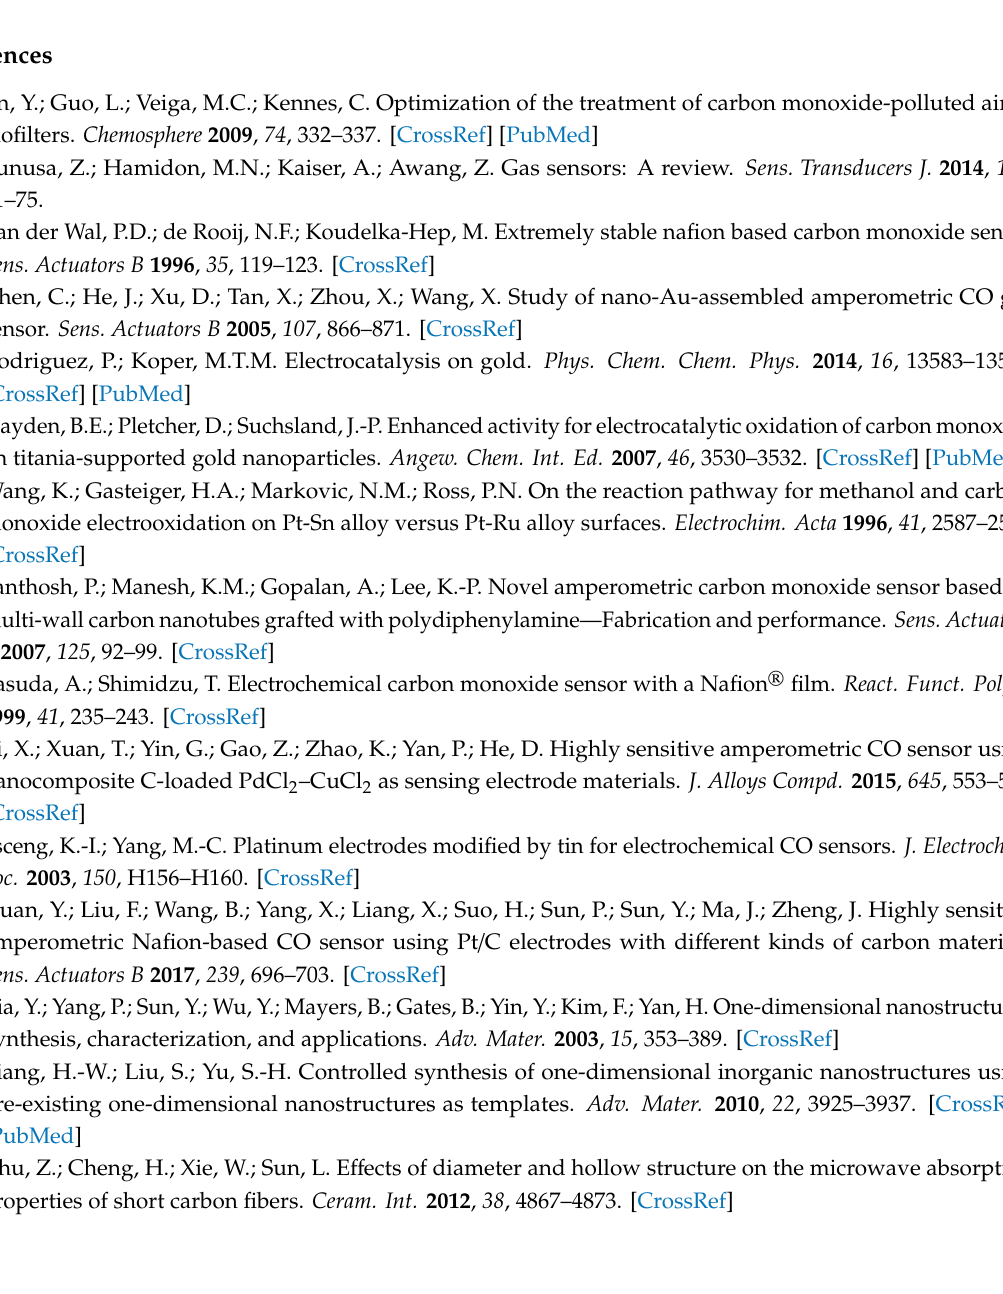
Figure S3: CV and EIS data obtained in 10 mM K 3 Fe(CN) 6 containing 0.1 M KCl, Figure S4: CV in 0.5 M H 2 SO 4 , Figure S5: LSV results of cPt for CO oxidation, Figure S6: Chronoamperometric response for 5 000 s, Table S1: Comparison